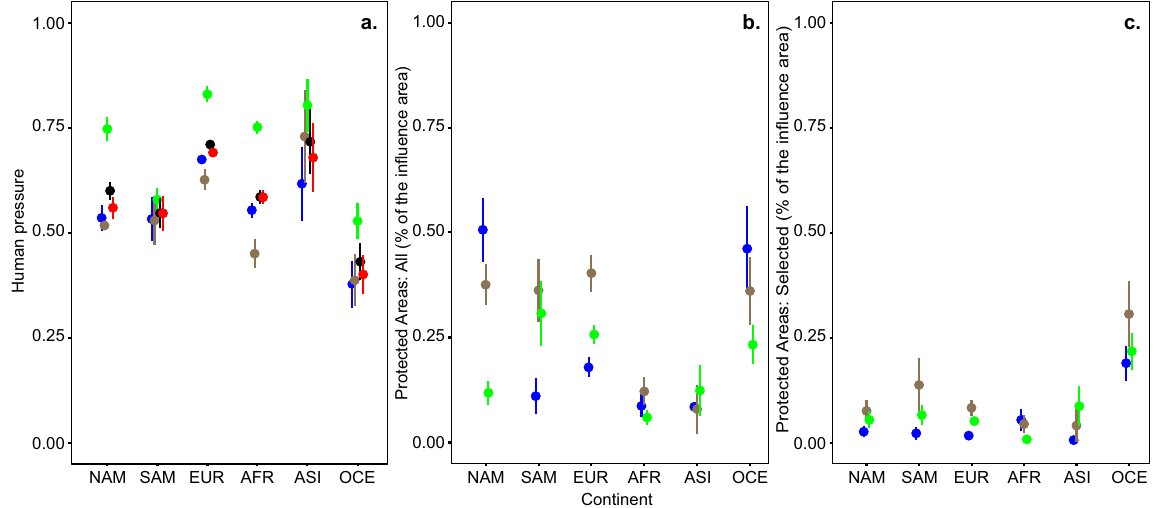
Figure 3. Mean ( ± confidence interval of 95%) per continent (NAM- North America, SAM- South America, EUR- Europe, AFR- Africa, ASI- Asia, OCE- Oceania) of: exposure of sampled estuaries to human activities and pressures ( a ), as well as percentage of coverage of those estuaries by protected areas ( b ) and by selected protected areas with IUCN I-IV categories ( c ). These three aspects were measured directly for: the estuary (brown), the adjacent coastal marine ecosystem (blue) and the adjacent freshwater ecosystem (green). In addition, human activity and pressure is also represented as: the mean of the three ecosystems (black), and the weighted mean of the three ecosystems (red; where, for each estuary, the weight of each ecosystem is given by the percentage of taxa from that ecosystem in the estuarine assemblage. Globally, higher intensity of human activities and pressures are found in sampled estuaries of Asia and Europe and lower in Oceania, regardless of the ecosystem of influence considered (marine, estuary, freshwater). Percentage of protected area (by selected PA with IUCN I-IV categories) is higher in sampled estuaries of